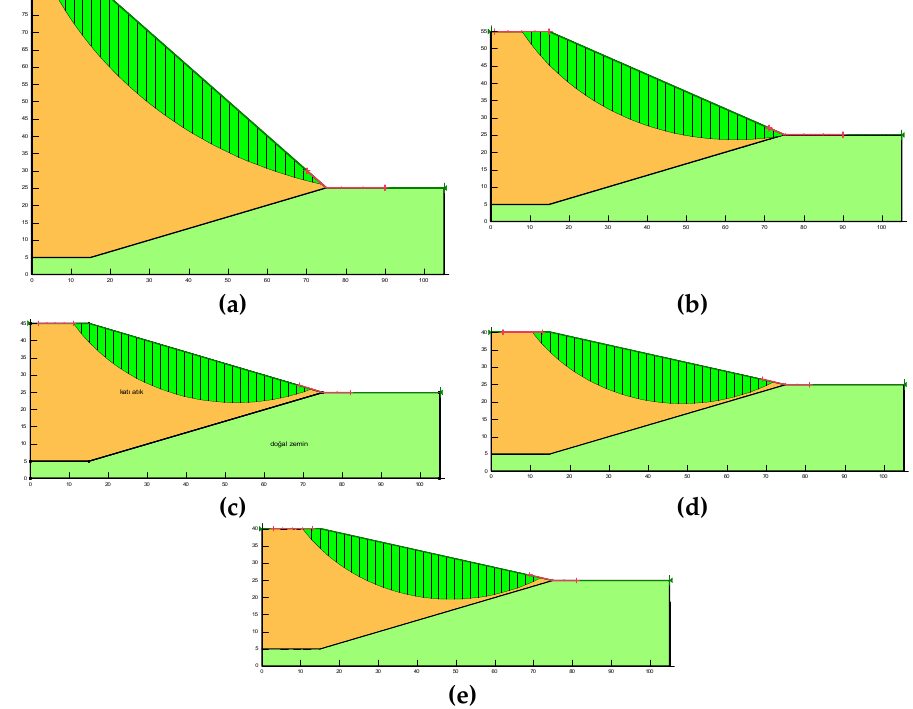
Figure 9. ( a ) 1V/1H; ( b ) 1V/2H; ( c ) 1V/3H; ( d ) 1V/4H; ( e ) 1V/5H. Failure planes (LEM).